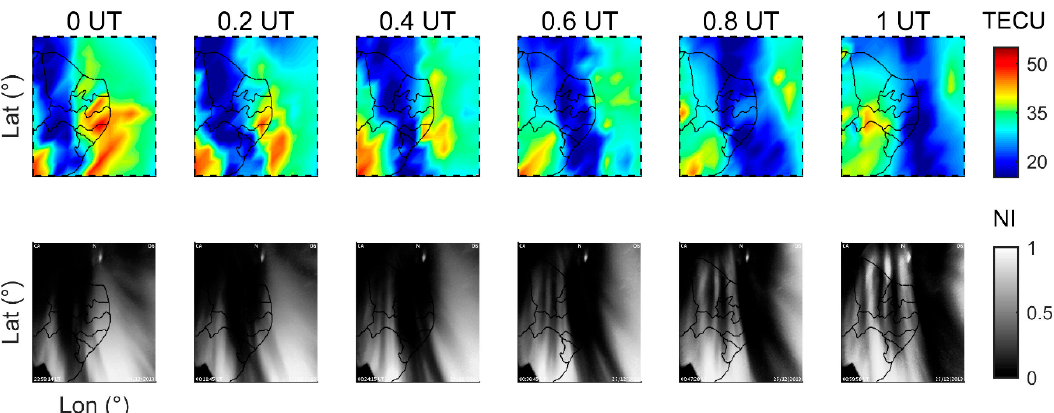
Figure 3. Example of a plasma bubble propagating through São João do Cariri (SJCI) in DOY 359 of 2013, detected by the VTEC reconstructions and the optical instruments.